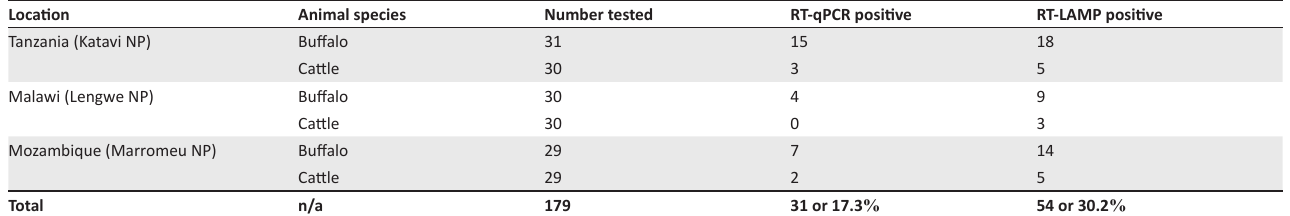
TABLE 2: Summary of results for oesophageal-pharyngeal samples tested during this study. Location Animal